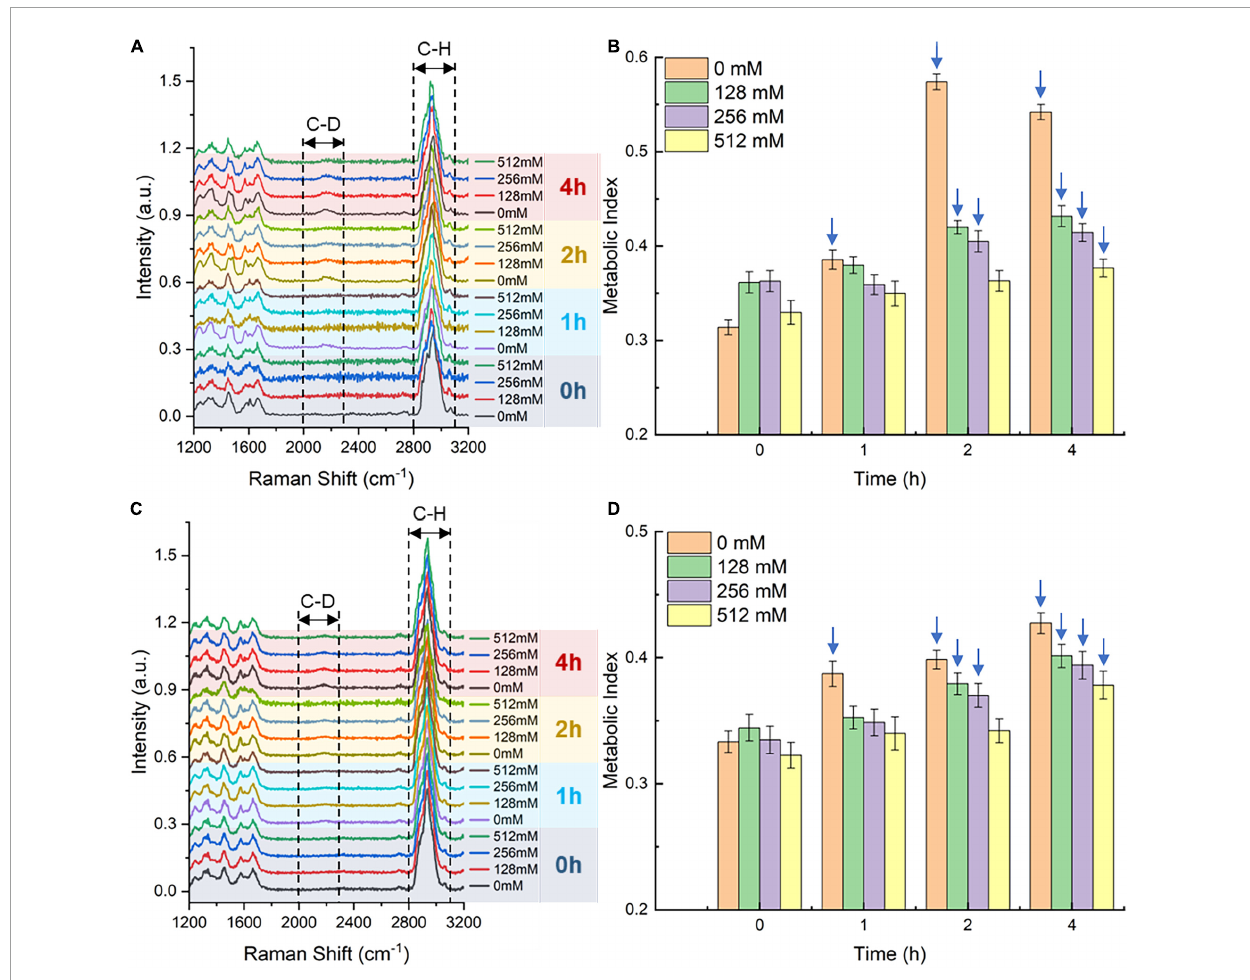
FIGURE3 Single-cell Raman spectra (SCRS) and metabolic indices of Escherichia coli (A,B) and Staphylococcus aureus (C,D) under 128-, 256-, and 512-mM SA after different deuterium labeling times. (A,C) The lines represent the average intensity of at least 30 replicates. SCRS of 0-mM SA serves as the negative control. The spectra were baseline corrected and normalized using a total area below all the peaks within the spectral range. (B,D) Metabolic-active bacteria are annotated with blue arrows. Error bars represent the standard deviation of at least 30 replicates. The metabolic index at the 0 h time point serves as the negative